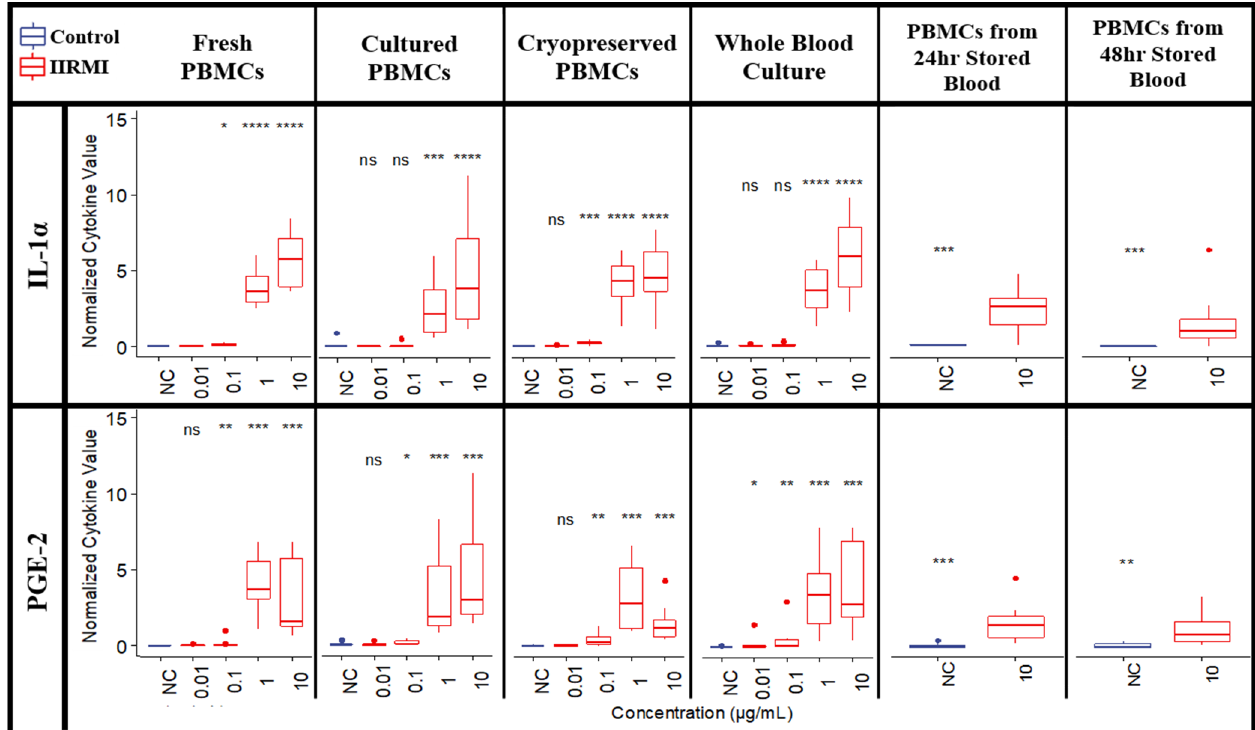
Figure 8. IL-1 α and PGE-2 Responses to Zymosan are Affected by PBMC and Blood Handling Conditions. PBMCs from 10 healthy human donors were exposed to various common laboratory handling conditions (isolated from fresh blood, cultured for 24 h, cryopreserved, isolated from blood refrigerated for 24 h or 48 h, and whole blood cultures) before being treated with IIRMIs for 24 h. Supernatants were analyzed for the presence of cytokines. Shown are the mean cytokine responses to zymosan (red), compared to a PBS negative control (NC, blue). The data for which statistical significance was not observed are marked with ns. Statistical significance is shown with an asterisk as follows: * p < 0.05; ** p < 0.01; *** p < 0.001; and **** p < 0.0001. Additional results, including zymosan-induced levels of the remaining five cytokines and the cytokine responses for the other nine IIRMIs, are available in Figure 5 (fresh PBMCs) and Figure S15 (all other experimental conditions).